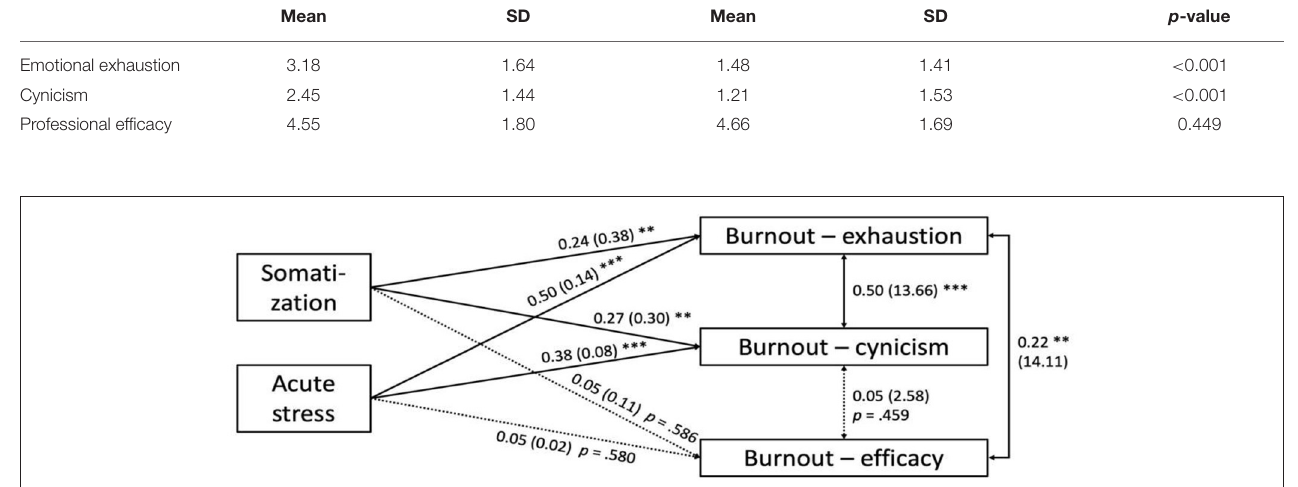
FIGURE 2 | Final SEM with the standardized coefficients followed by the unstandardized coefficients in parentheses. ** p < 0.005, *** p < 0.001.